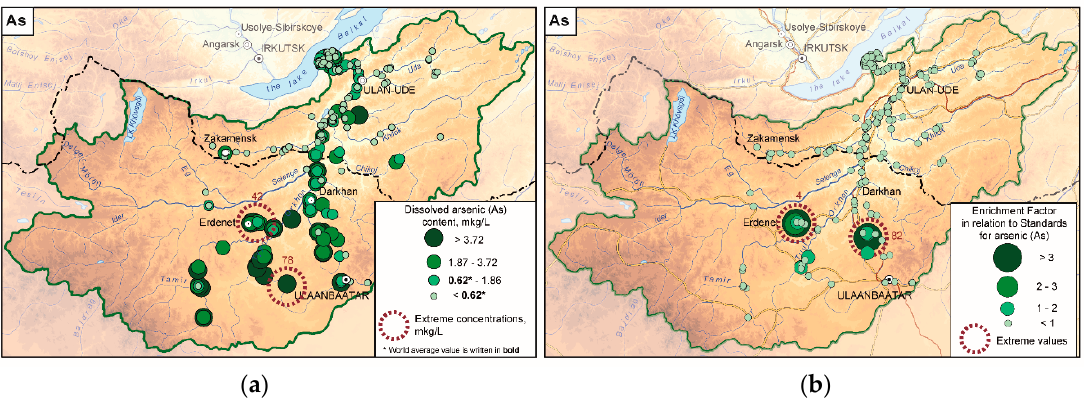
Figure 7. Dissolved As levels in the river waters of the Selenga basin ( a ) and EF of the As in relation to WHO, MNS, and MPC D Standards value for drinking water ( b ).